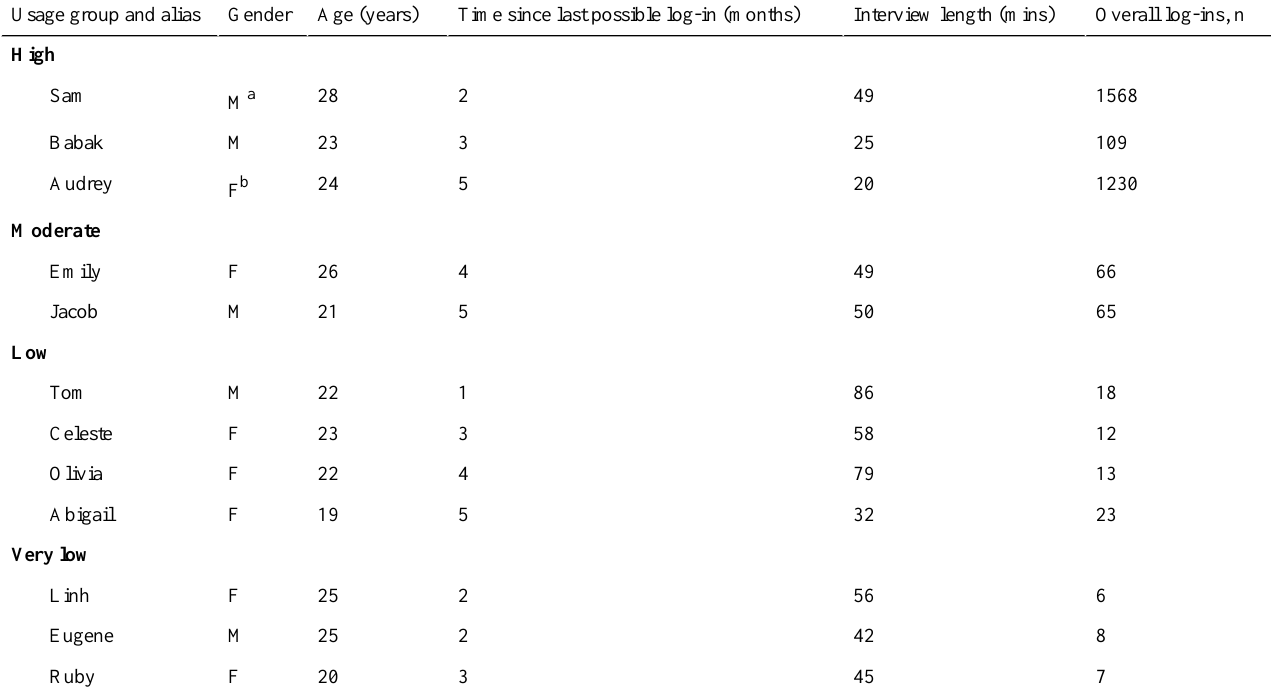
Table 2. Descriptive summary of participant usage groups, alias, gender, age, follow-up time, length of interview, and overall log-ins to the Horyzons